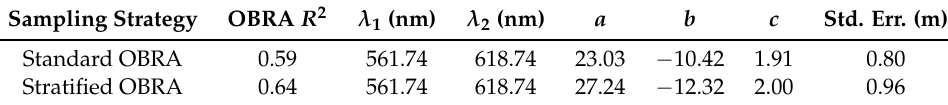
Table 2. Stratified Optimal Band Ratio Analysis (SOBRA) results for Deschutes River image spectra. λ 1 and λ 2 refer to the numerator and denominator wavelengths in the quadratic OBRA relation (cid:104) R ( λ (cid:105) 1 ) d = aX 2 + bX + c , where X = ln . The first row of the table lists the results for standard R ( λ 2 ) Optimal Band Ratio Analysis (OBRA) applied to the original field data set, without stratification.